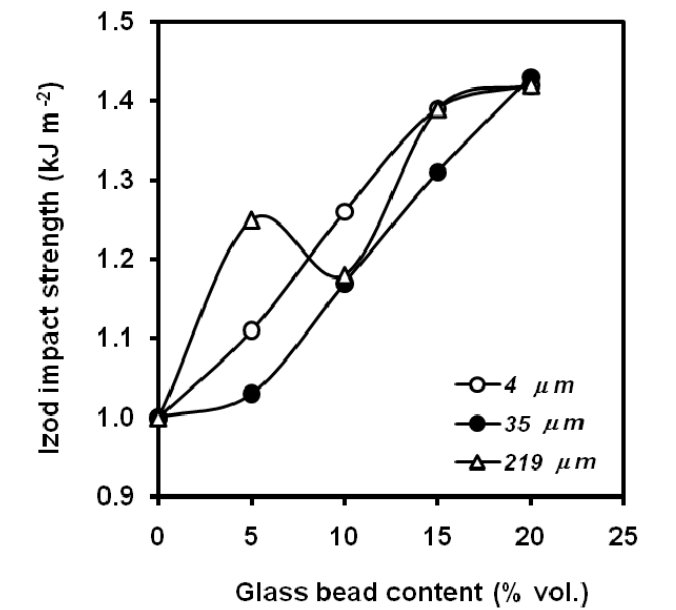
Figure 16. Dependence of the notched Izod fracture energy on the glass bead content for composites with several particle sizes (adapted from